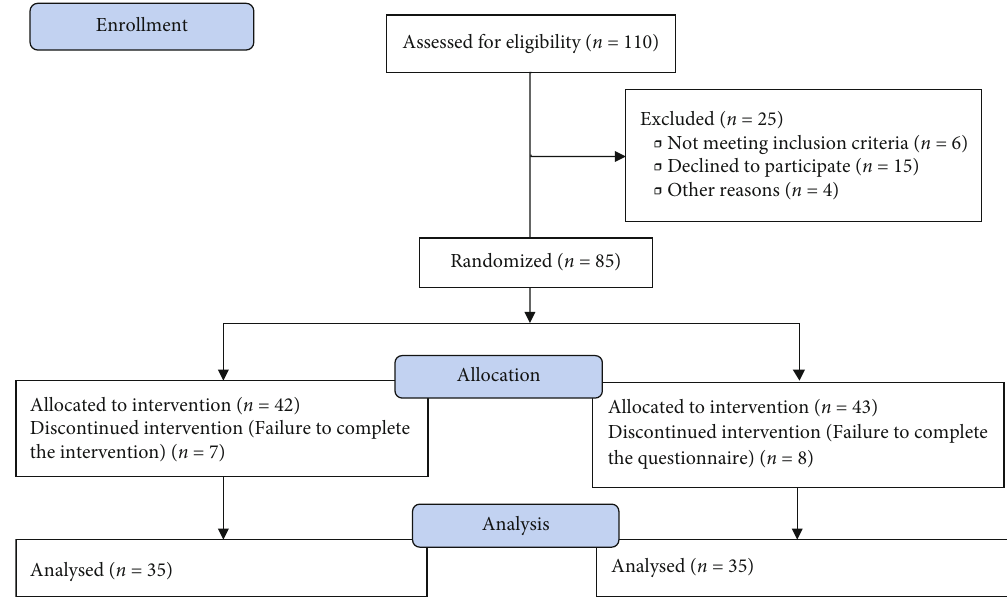
Figure 1: CONSORT fl ow